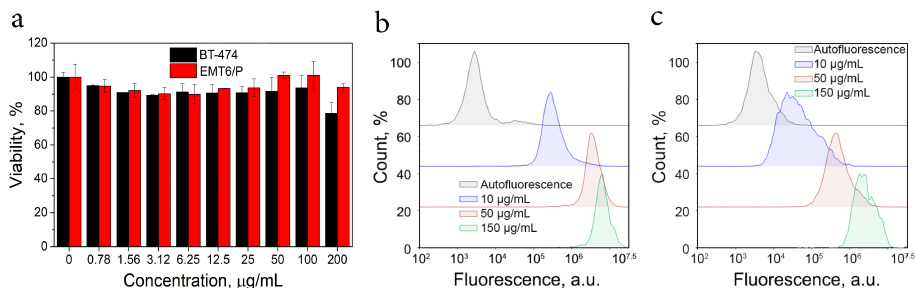
Figure 5. In vitro activity of Ab-DopSycCy7@Ferria composite. Cytotoxicity of the hybrid material measured on BT-474 and EMT6/P cell lines ( a ); flow cytometry fluorescence signal of BT-474 cells labeled with the composite ( b ); flow cytometry fluorescence signal of EMT6/P cells labeled with the composite at various concentrations ( c